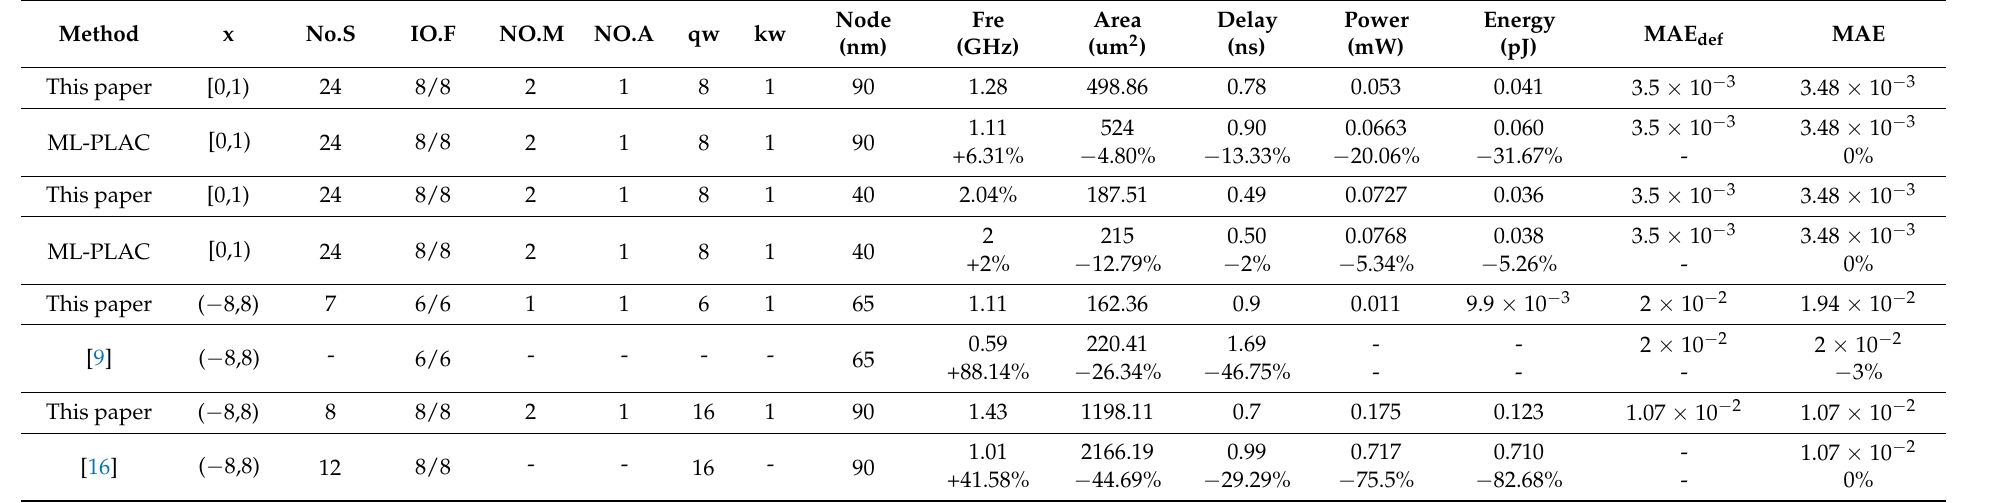
Table 7. Performance comparison for tanh ( x )